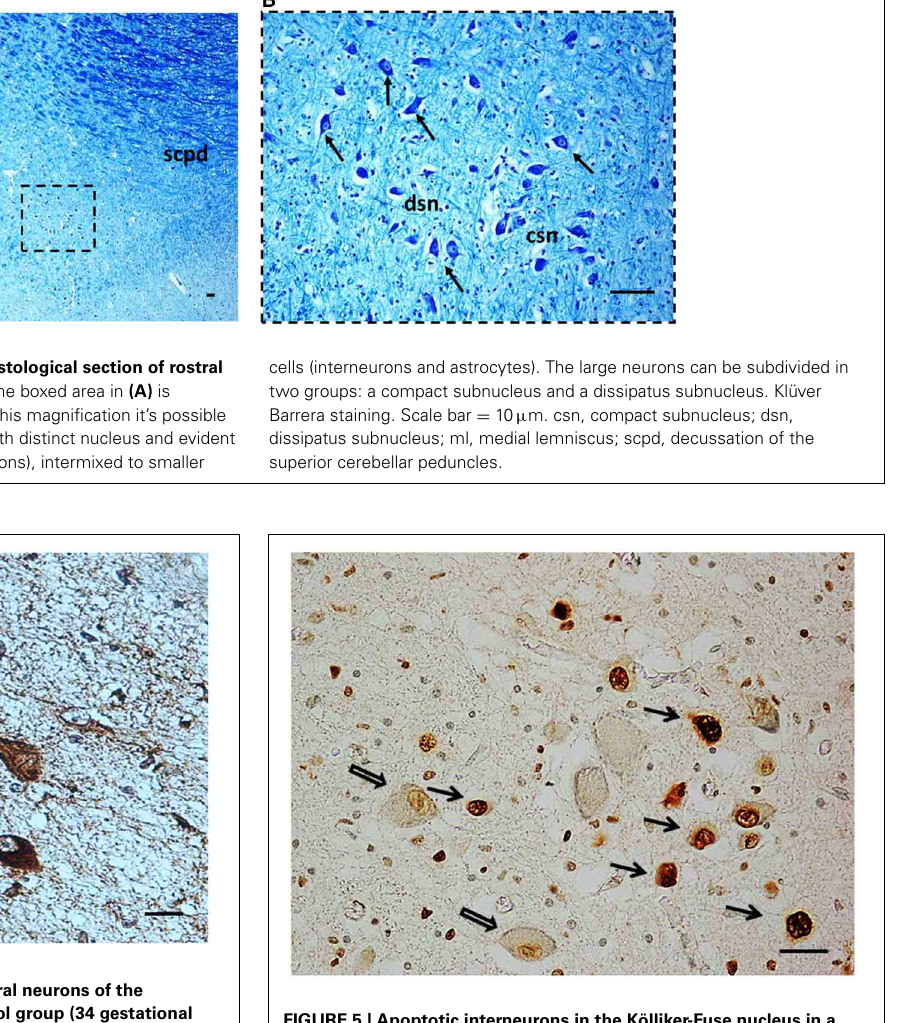
FIGURE 5 | Apoptotic interneurons in the Kölliker-Fuse nucleus in a newborn of the control group (2 month-old). Full arrows indicate immunopositive interneurons; empty arrows indicate some of the immunonegative large neurons. TUNEL metod immunostaining. Scale bar = 10 µ